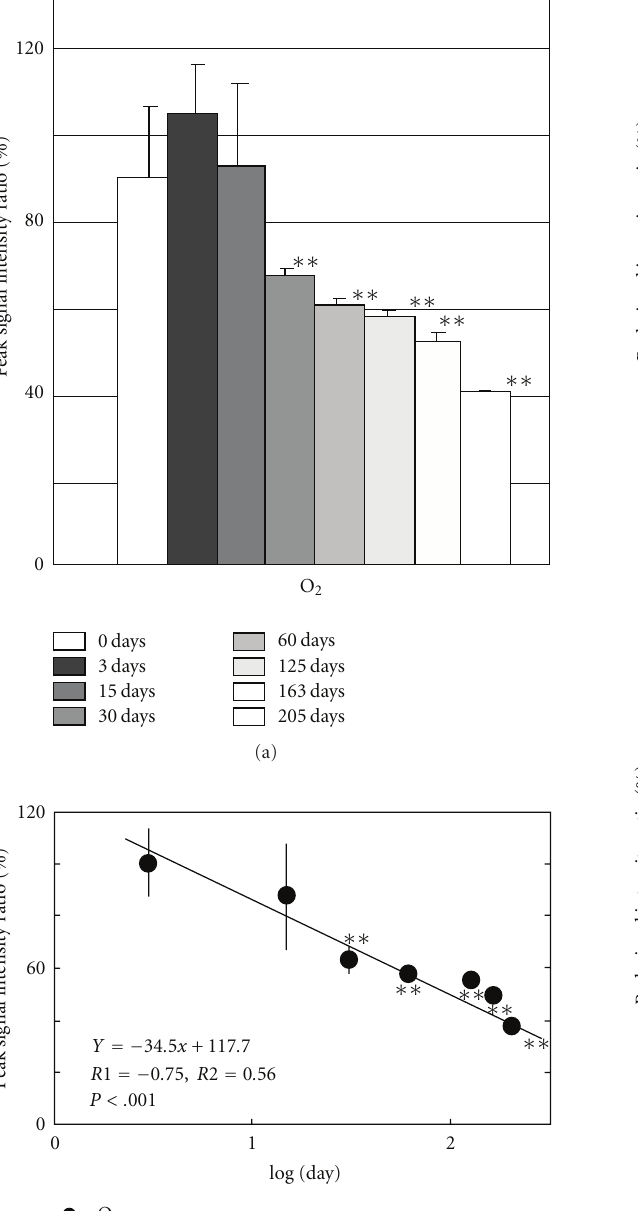
Figure 5: (a) Postmortem DMPO-adduct signal intensity in mouse heart. The columns and the lines show the postmortem signal intensity ratios of brain and S.E.M. of the means ( n = 8). The y - axis shows the percentage of peak signal intensity ratio, which was calculated by assuming that the intensity of MnO (500 nmol/L) was 100%. ∗ P < . 05, ∗∗ P < . 01, versus 0 days. (b) Time course of postmortem DMPO-adduct signal intensity ratio in mouse heart. The y -axis shows the percentage of peak signal intensity, which was calculated by assuming that the intensity at 3 day postmortem was 100%. X -axis is expressed in Log(day). ∗ P < . 05, ∗∗ P < . 01, versus 3 days. The regression lines, correlation coe ffi cient ( R1 ), contribution rate ( R2 ), and the probability of error ( P -value) were calculated.